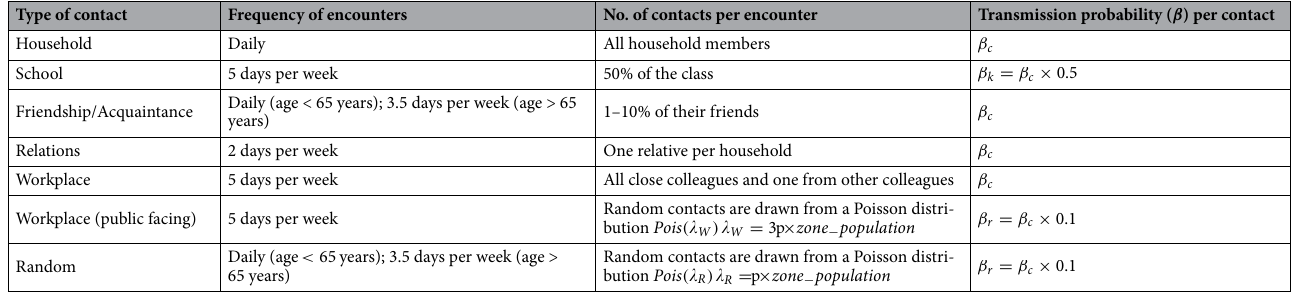
Table 1. Contact type and transmission probability for social network based and random